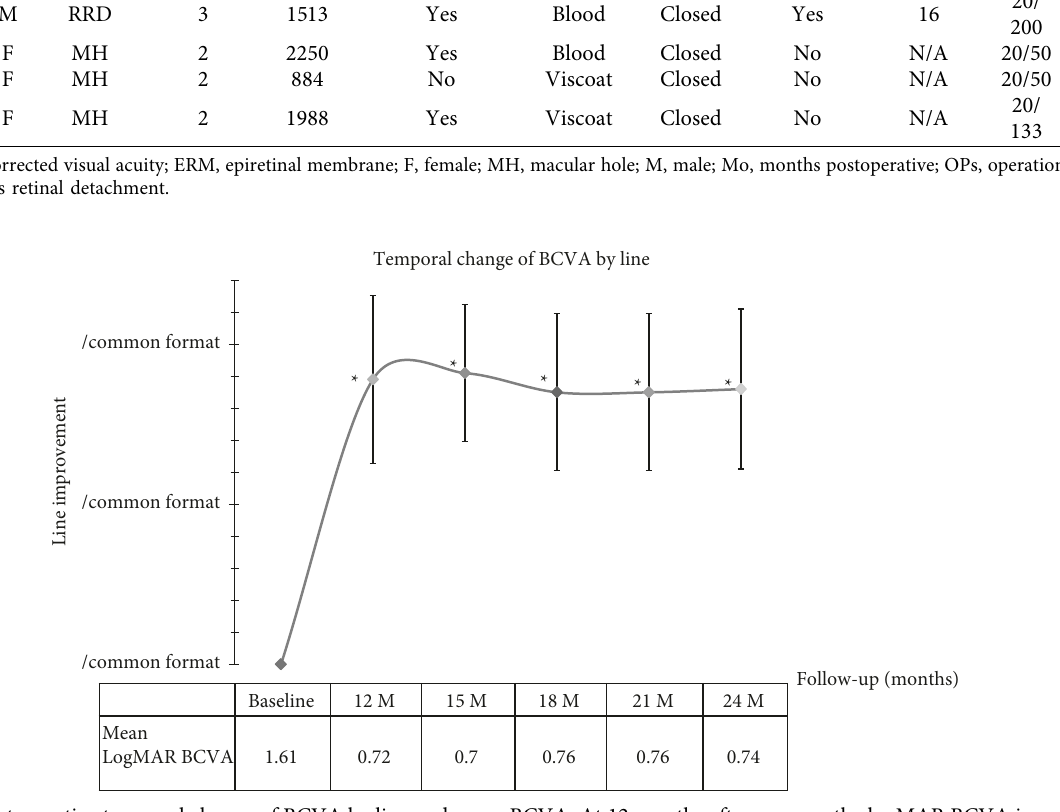
Figure 1: Postoperative temporal change of BCVA by line and mean BCVA. At 12 months after surgery, the logMAR BCVA improved to 0.72 ± 0.30 and the mean line improvement was 8.9 ± 2.6 lines from baseline ( p < 0 . 001). The vision remained constant after that. The mean line improvement from baseline was 9.1 ± 2.1 lines at 15 months following surgery ( p < 0 . 001). The mean logMAR BCVA improved by 8.7 ± 2.5 lines from baseline to 0.74 ± 0.30 at 24 months ( p < 0 . 001). Table 2: Functional change between the eyes with or without cystic change. Status of retinal